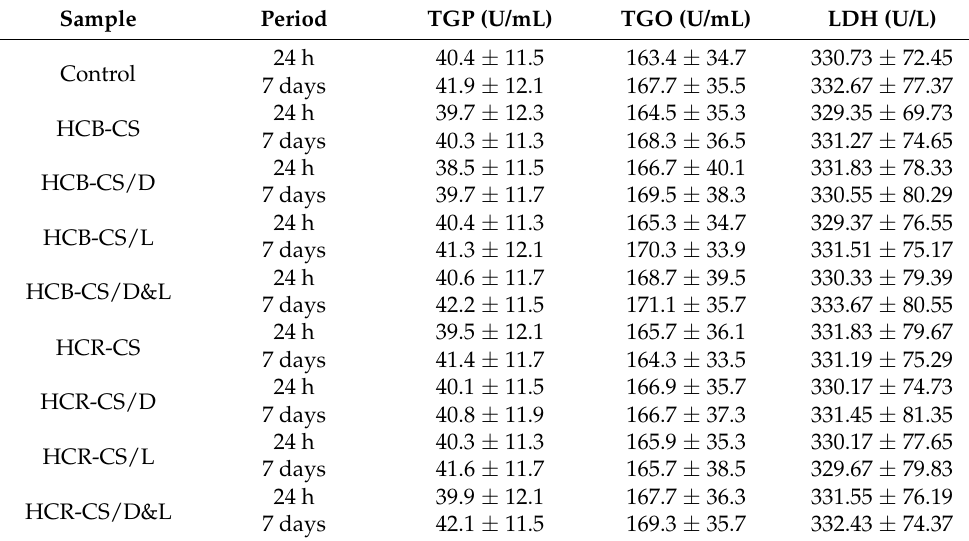
Table 6. Changes in glutamic-oxaloacetic transaminase (TGO), glutamic-pyruvic transaminase (TGP), and lactate dehydrogenase (LDH) serum values for animals that received electrospun samples. Values are expressed as arithmetic mean ± SD of the TGO, TGP, and LDH average values for 5 mice per batch.